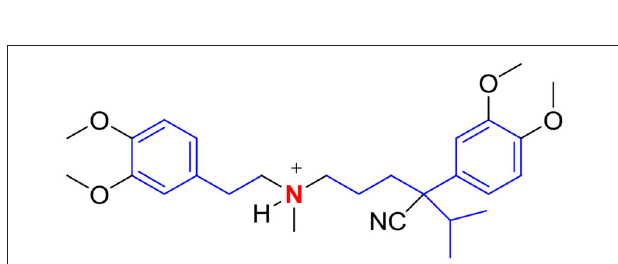
FIGURE 8 | Verapamil is a cationic amphiphile with a basic tertiary amino group (red) and lipophilic residues